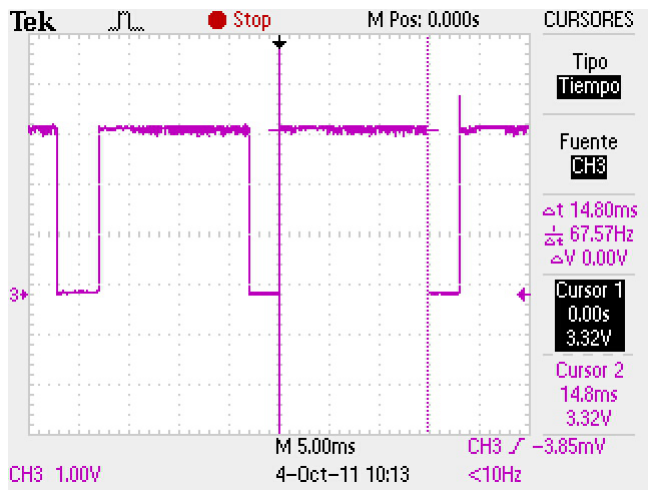
Figure 10. Algorithm CPU